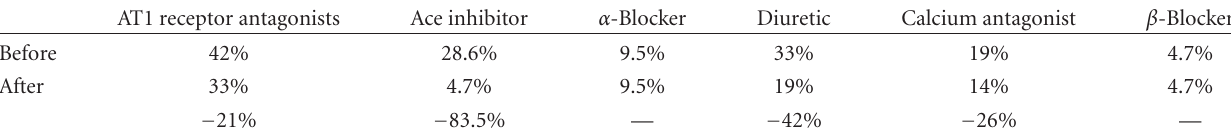
Table 6: Antihypertensive drugs taken by PHPT patients at baseline (before) and after 12 months from surgery. AT1 receptor antagonists Ace inhibitor α -Blocker Diuretic Calcium antagonist β -Blocker Before 42% 28.6% 9.5% 33% 19% 4.7% After 33% 4.7% 9.5% 19% 14% 4.7% −